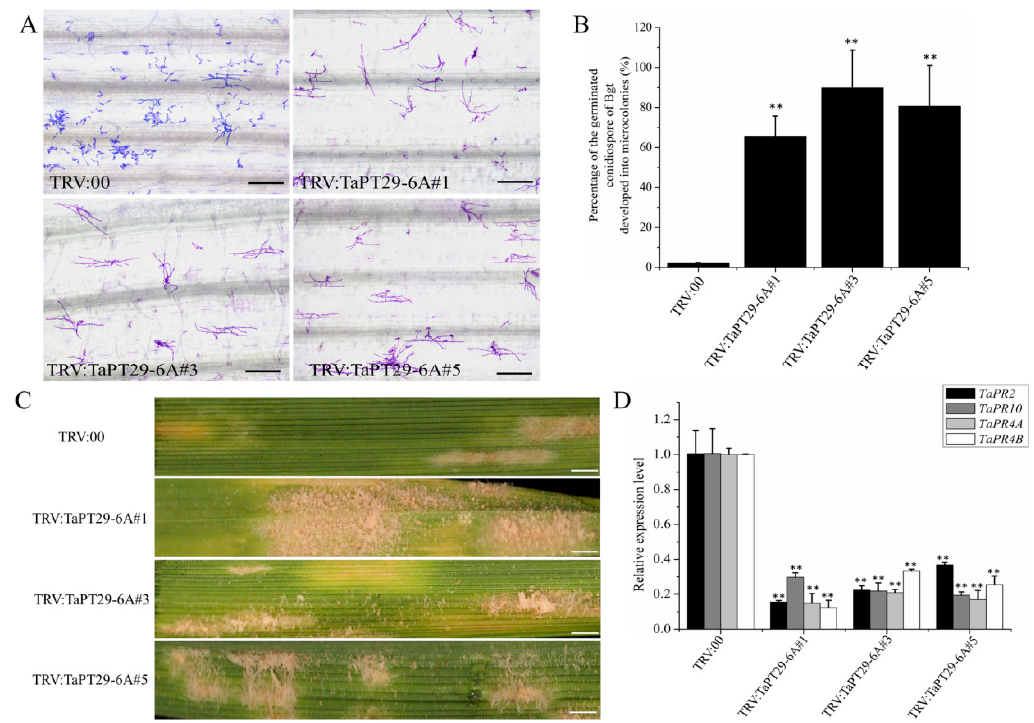
Figure 9. Silencing TaPT29-6A enhanced susceptible to Bgt . ( A ) Microscopic images showing Bgt microcolony formation on leaves of TRV:00 plants and TaPT29-6A -silenced plants, 60 h after inoculation. Scale bar = 12.5 µm. ( B ) Percentages of germinated Bgt conidiospores on the TRV:00 plants and TaPT29-6A -silenced plants 60 h after infection. ( C ) Macroscopic phenotypes of Bgt infection on leaves of TRV:00 plants and TaPT29-6A -silenced plants. Scale bar = 5 mm. ( D ) Results of qRT-PCR analysis of relative transcript levels of TaPR4A/B and TaPR2/10 in TaPT29-6A -silenced and TRV: 00 plants. Double asterisks indicate significant differences between the plants at P ≤ 0.01, according to a t test.